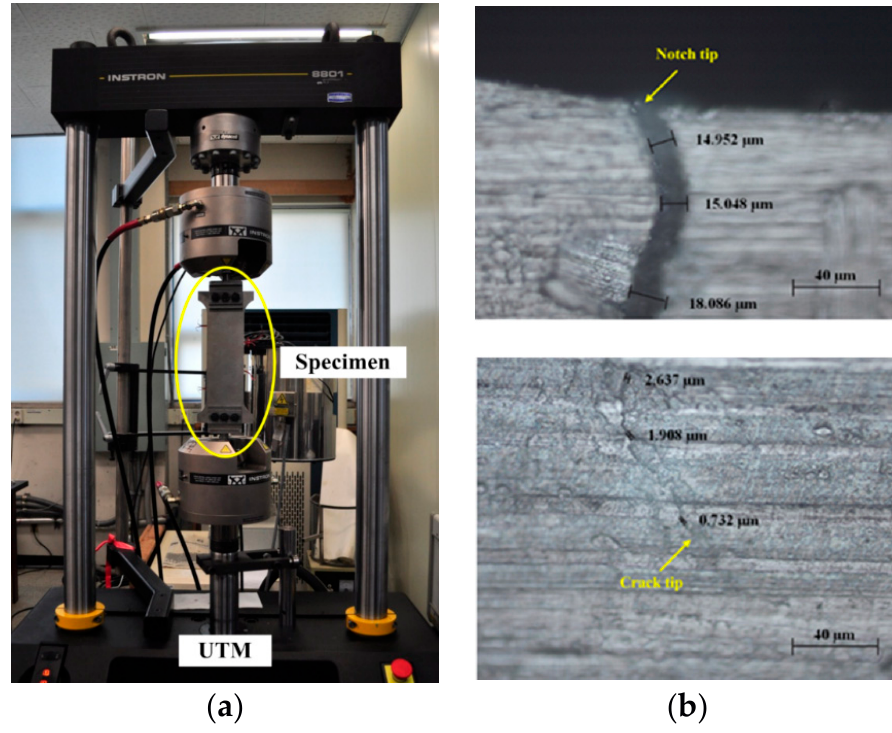
Figure 7. Creation of a fatigue crack through cyclic loading tests: ( a ) Tensile-loading test setup with a specimen and ( b ) Microscopic images and crack widths. UTM: universal testing machine.